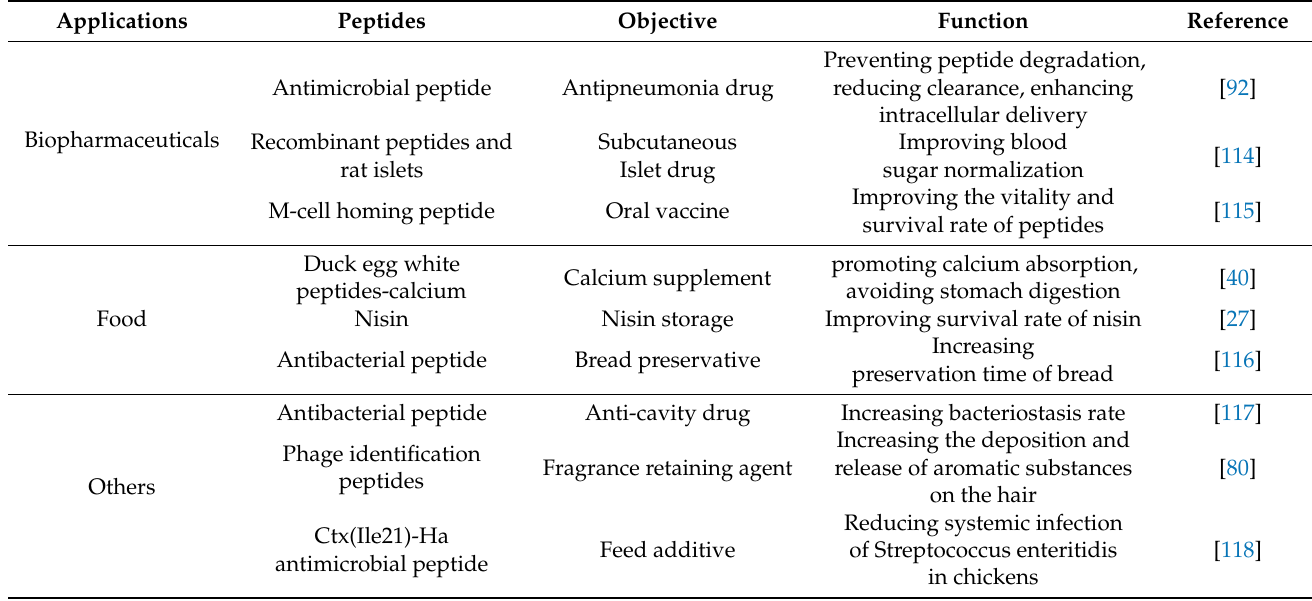
Table 3. Application of peptides microcapsules in different